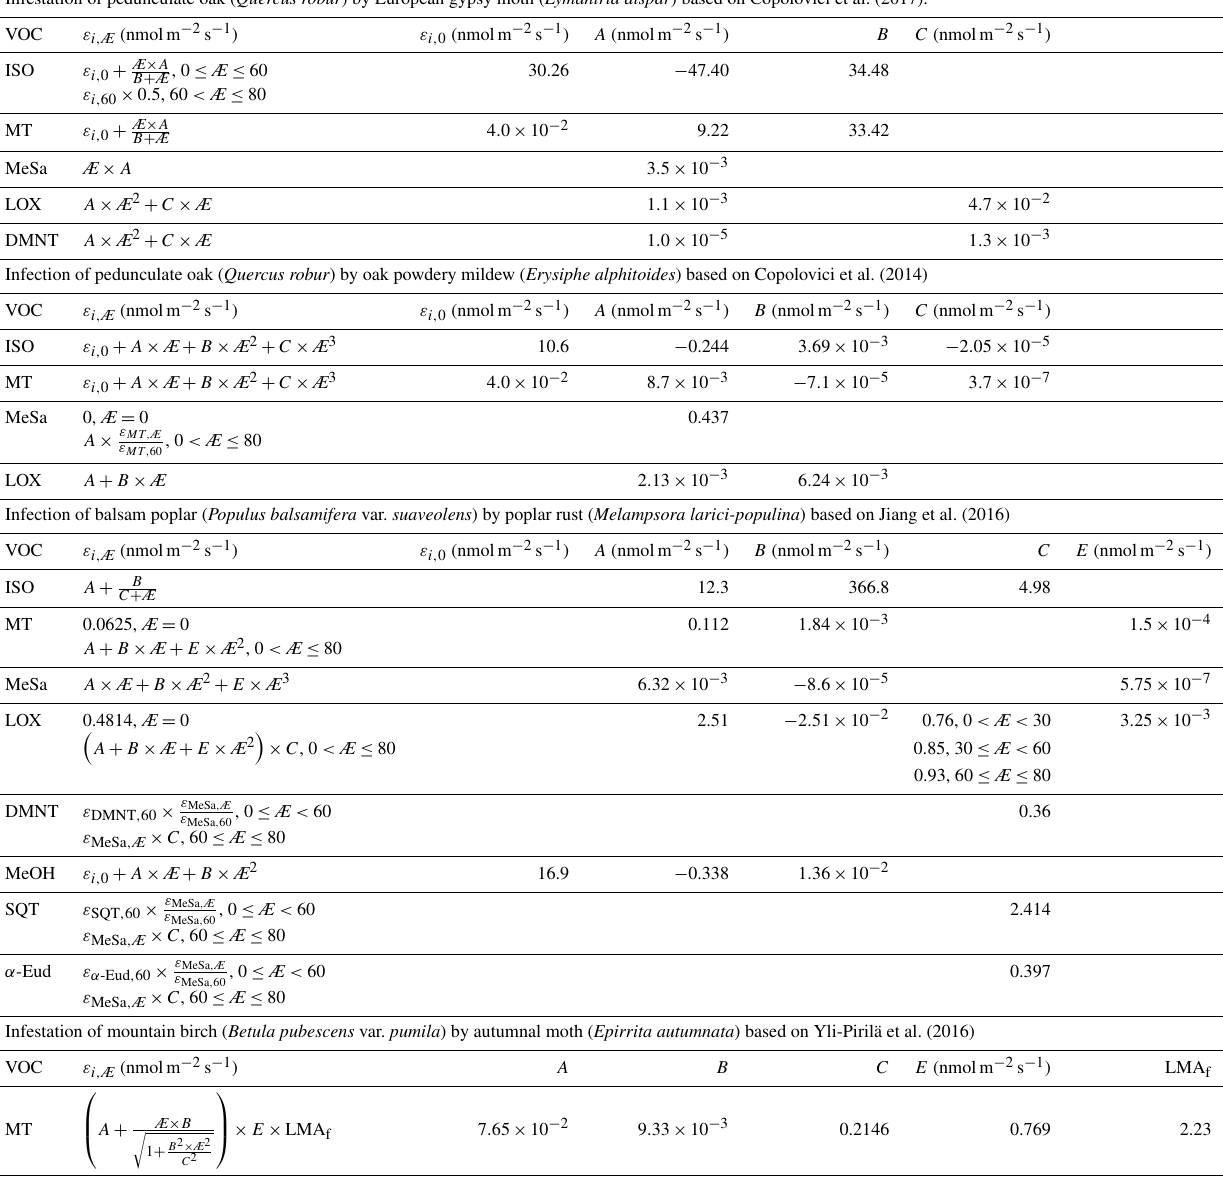
Table 1. Equations to calculate the emission factors ( ε i, Æ , in nmolm − 2 one-sided LAIs − 1 ), as a function of the degree of stress ( Æ ), together with the parameters needed for the equations. The equations are valid for infection levels ranging from 0% to 80% unless otherwise stated. The emission factors for oak and poplar are presented without the downscaling by a factor of 0.57 (see Sect. 2.4). LMA f is the fraction of the leaf mass area of leaves growing on mature mountain birch divided by leaves growing on mountain birch seedlings, which is included so that the emission factors for mountain birches are also representative of mature trees. ISO stands for isoprene, MT stands for monoterpenes, MeSa stands for methyl salicylate, LOX stands for lipoxygenase pathway volatile compounds, DMNT stands for 4,8-dimethyl-1,3,7-nonatriene, MeOH stands for methanol, SQT stands for sesquiterpenes, and α -Eud stands for α -Eudesmol. Infestation of pedunculate oak ( Quercus robur ) by European gypsy moth ( Lymantria dispar ) based on Copolovici et al.